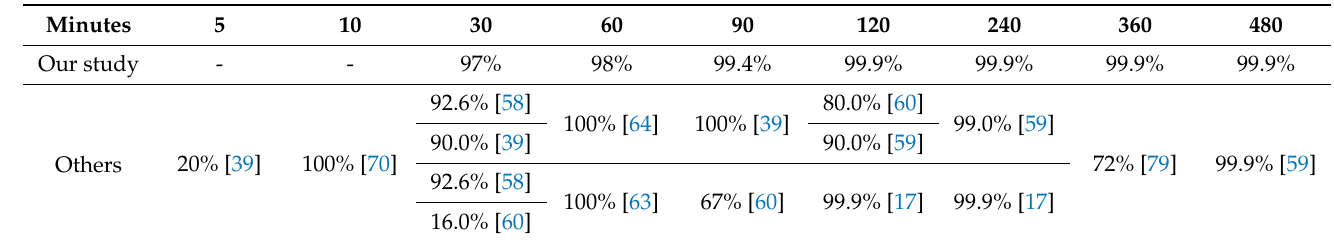
Table 1. Comparison of the efficacy of TiO 2 -containing polymer composites in E. coli with our study and previously published